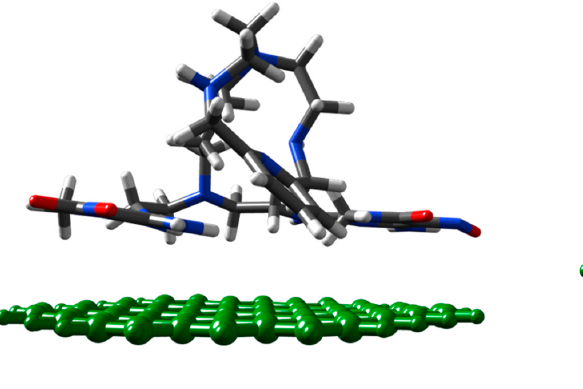
Figure 8. Lateral ( a ) and top ( b ) views of the minimum energy conformation of G-(H 2 L). Color code: grey, C; green, graphene C; white, H; red, O; blue, N.